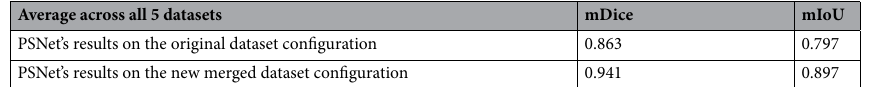
Average across all 5 datasets